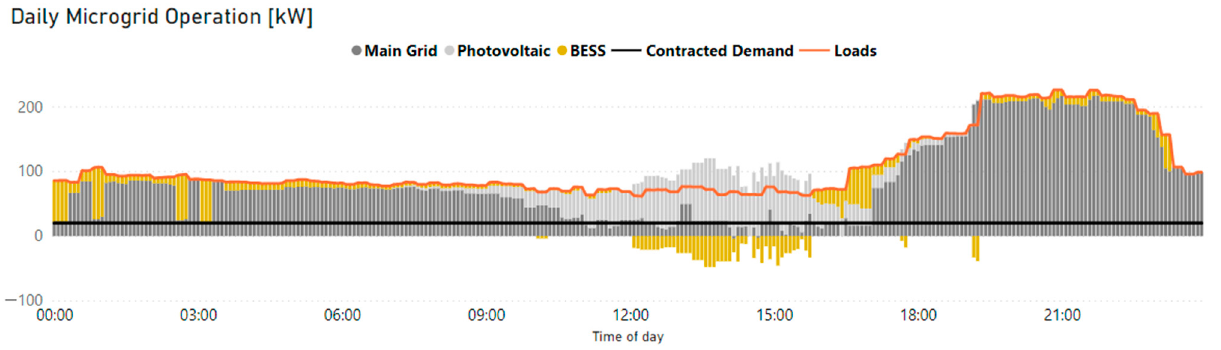
Figure 11. Daily microgrid operation for a contracted demand of 20 kW.